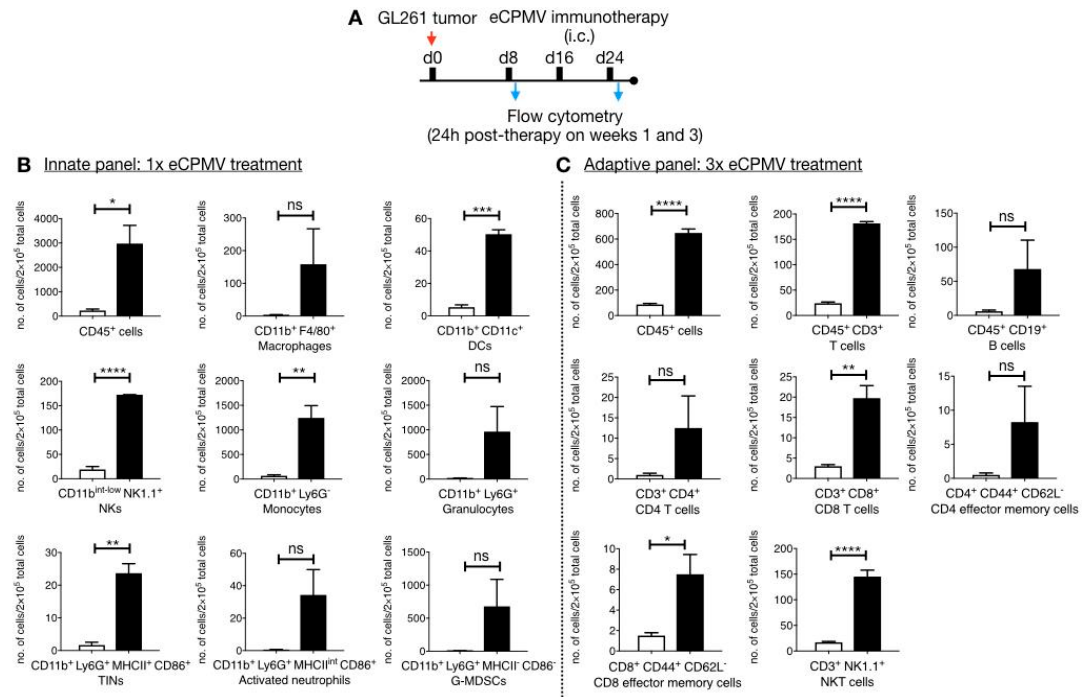
Figure 3. Flow cytometry analysis to characterize immune infiltration in the brain parenchyma. ( A ) GL261 glioma bearing C57BL6 mice ( n = 3) were treated 1× or 3× with eCPMV immunotherapy